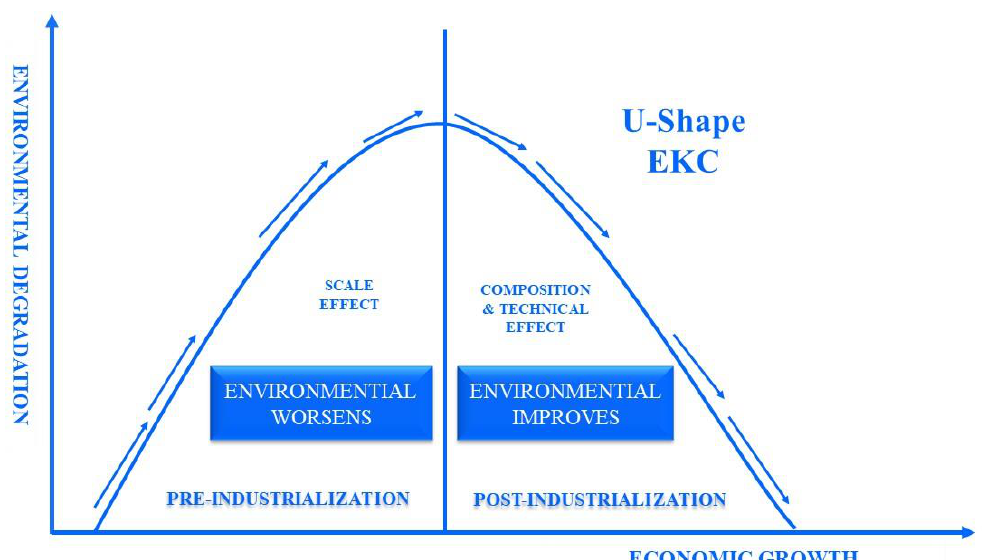
Figure 1. EKC with U-shape, source: author ’ s own illustration. Numerous studies highlight the crucial and essential function of green energy from renewable resources, including wind, solar energy, biofuel, waves, tides, and geothermal heat, to slow down environmental deterioration over the previous few decades [14]. They also describe the advantages of using eco-friendly green energy sources to reduce CO 2 emissions. Similarly, Kirikkalli and Sowah [15] recognized the benefits of using green en- ergy to help development in economic and environmental spheres. There are many ad- vantages to meeting energy needs with natural renewable energy sources, including re- ducing imported non-renewable energy sources. Although the use of renewable energy is on the rise, consumption of these resources is still constrained due to their generally high cost and other technical issues in many nations [16]. Innovative, environmentally friendly green technology can significantly contribute to the fight against all environmental pollu- tion-related problems. Innovation in green technology has been employed to revitalize the ecosystem [17]. Green technology is a viable solution for eliminating carbon emissions by incorporating environmentally friendly technologies into current operations to achieve maximum growth at the lowest possible cost to the environment [18].To achieve carbon neutrality, the intergovernmental panel on climate change (IPCC) also stressed the need to cut and phase out fossil fuel use, utilize more renewable energy, and increase energy efficiency in its special report on global warming of 1.5 °C. The panel also stressed the significance of implementing these measures in cities to attain carbon neutrality [19]. Ad- ditionally, it is necessary to encourage carbon reduction or absorption in terrestrial and aquatic ecosystems to attain net-zero carbon emissions and environmental sustainability [20]. The choice of the E7 is driven by the expansion of the global economy, which has afforded newly industrialized nations the potential future that might transform the global economy and make it even more resilient and vibrant. Any emerging country ’ s growth trajectory can be predicted using financial, economic, and demographic factors. There is still a long way to go before the emerging seven countries become a global powerhouse, navigating other economies through the geopolitical seas and choppy economic divi- dends in the future. This is because several internal and external complexities and policies affect people in these nations. Due to their fast-rising rates of energy consumption and the